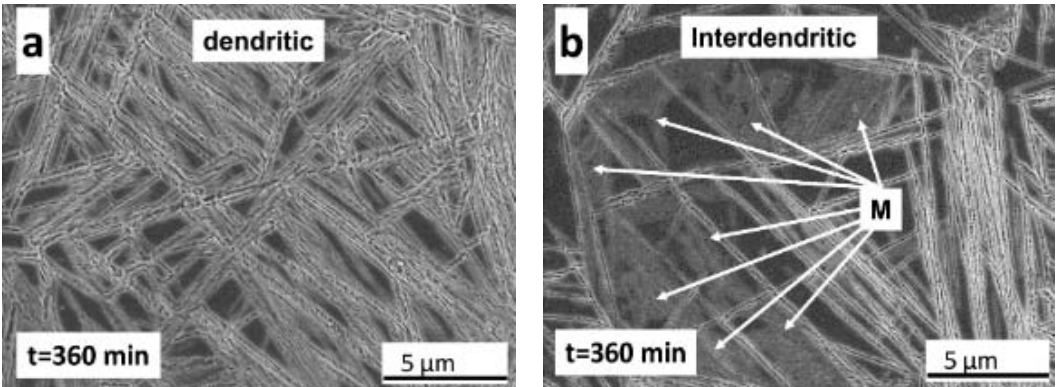
Figure 16. FEG-SEM micrographs corresponding to sample austempered at 230 ◦ C for 360 min. ( a ) Dendritic region, ( b )Interdendritic region. M symbol stands for the martensitic phase. Microstructure etched with Nital 2%.